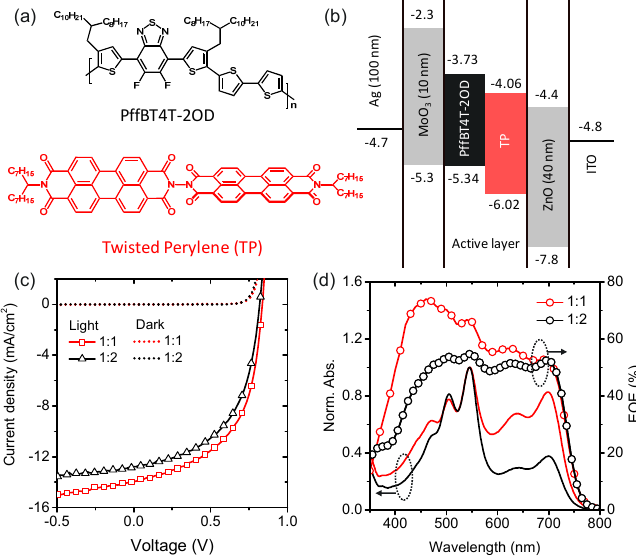
Figure 1. ( a ) Structure of PffBT4T-2OD and twisted perylenediimide (TP). ( b ) Energy levels of the materials in the inverted device structure used in this study. ( c ) J - V characteristics of PffBT4T-2OD:TP devices with different compositional ratios of 1:1 (red) and 1:2 (black) under illumination of an AM 1.5G solar simulator (100 mW cm -2 ). ( d ) EQE and absorption spectra of PffBT4T-2OD:TP at different weight ratios of 1:1 (red) and 1:2 (black). Table 1. Device characteristics of PffBT4T-2OD:TP blends.